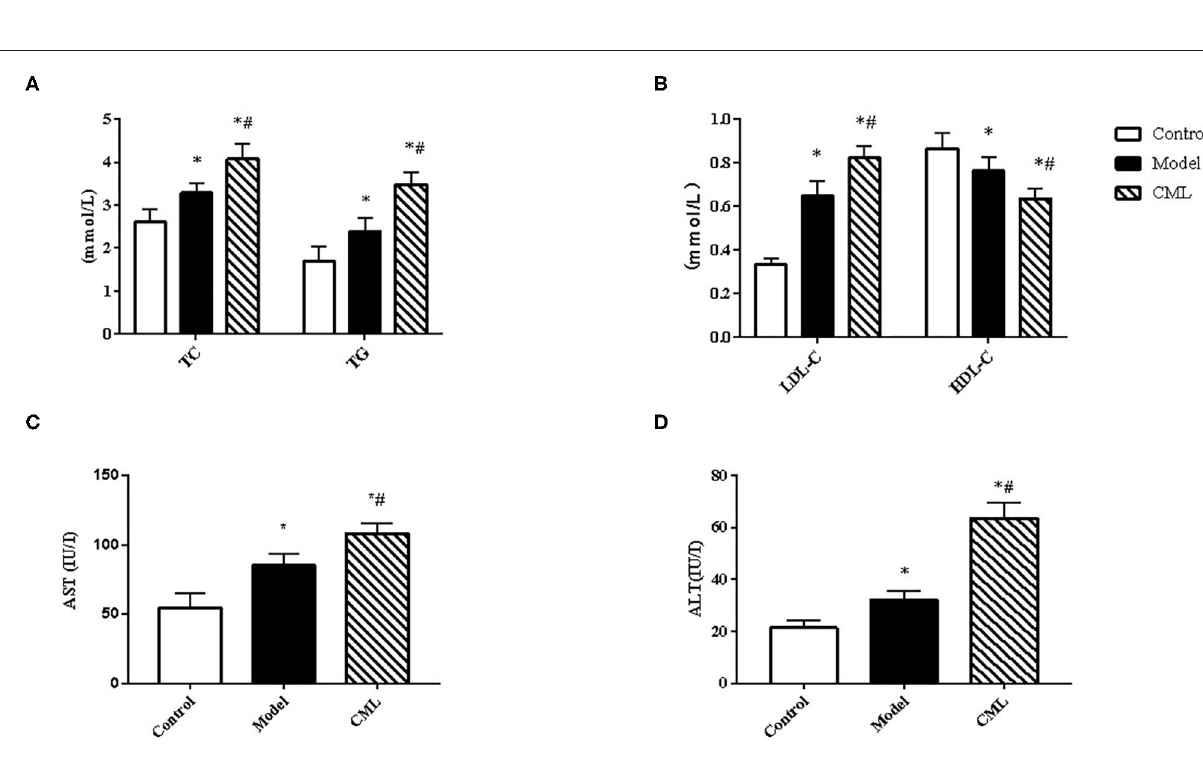
Frontiers in Medicine | www.frontiersin.org